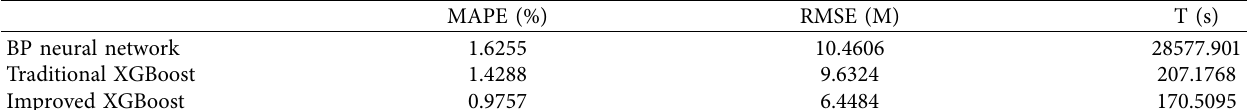
Table 2: The total error and time of the selected test set.